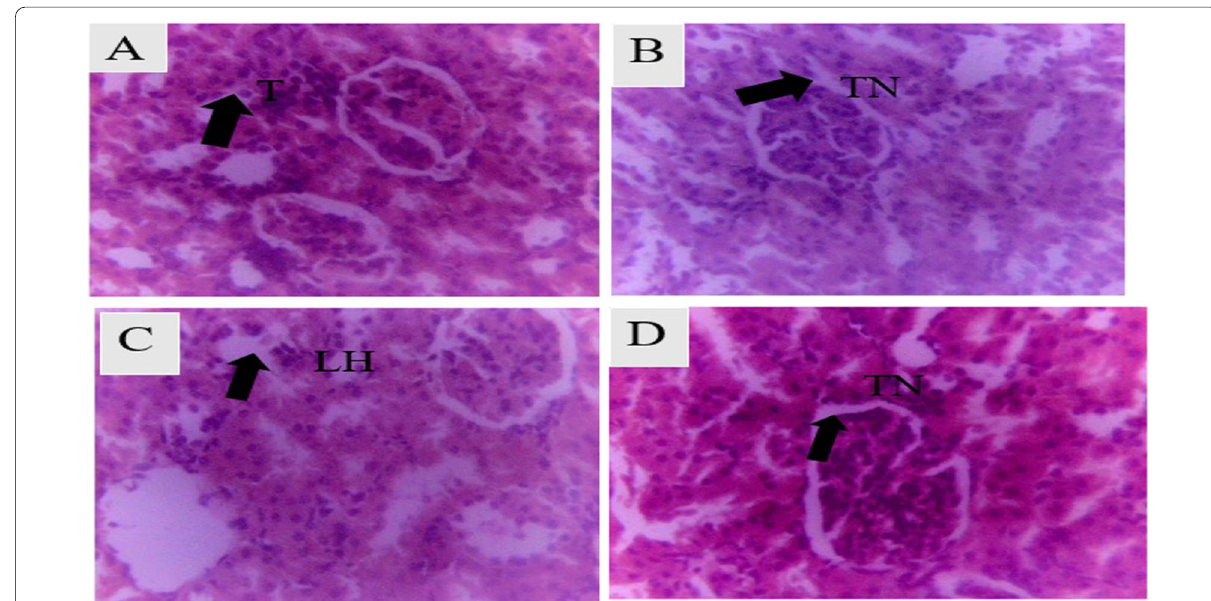
Fig. 3 Photomicrographs of kidney sections of rats following 28-day oral administrations of Culcasia angolensis leaves extract (CAE) (haematoxylin and eosin-stained at